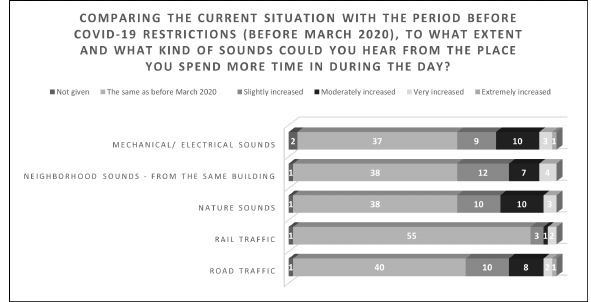
Figure 8: Comparison between the period before COVID-19 restric- tions and the current situation, concerning personal habits.